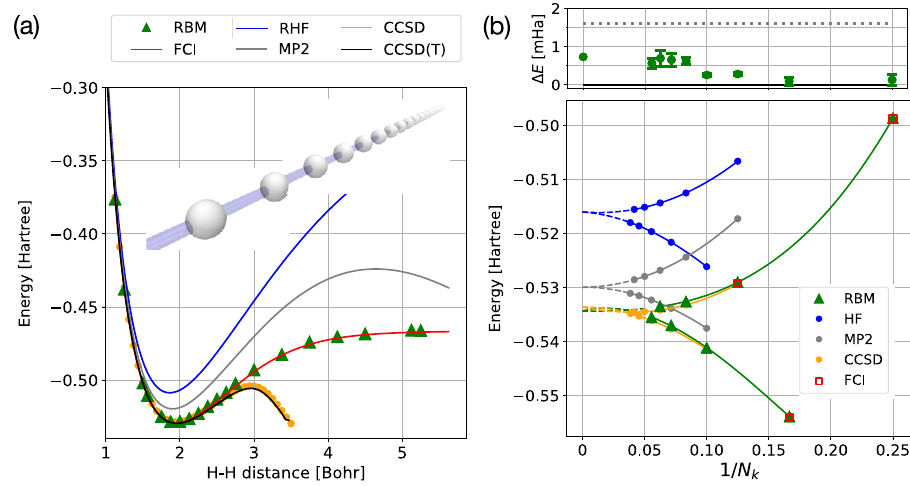
Fig. 2 Solving the ground state of the linear hydrogen chain using the minimal STO-3G basis set. a The potential energy curve calculated by the restricted Boltzmann machine (RBM) agrees with the full con fi guration interaction (FCI) method within chemical accuracy (1.6 mHa) for any atom separation d H . This indicates that the RBM states are capable of describing both the weakly and strongly interacting regimes, where gold-standard techniques, such as coupled-cluster singles and doubles (CCSD) shown by the yellow line and CCSD with perturbative triple excitations (CCSD(T)) in black line, break down. The results by restricted Hartree – Fock (RHF) and second-order Møller – Plesset perturbation theory are indicated by blue and gray lines, respectively. A unit cell consists of four hydrogen atoms placed at even intervals, and two k -points are sampled from a uniform grid. b Finite-size scaling of the ground-state energy up to N k = 18 and its deviation from the FCI (Nk ≤ 8Nk ≤ 8) or CCSD(T) (Nk > 8Nk > 8), Δ E , at near-equilibrium d H = 2. The results show excellent agreement with conventional methods even in the thermodynamic limit N k → ∞ . Here, the unit cell consists of a single hydrogen atom, and hence the maximum number of spin orbitals considered here is 36. The error bars denote the standard deviation of the estimation by the Monte Carlo sampling.